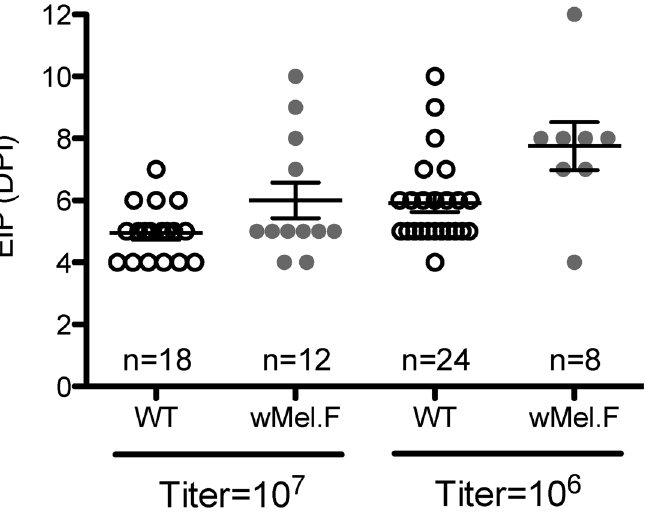
Fig 1. Extrinsic incubation period (DPI) of WT (white) and Wolbachia infected ( w Mel.F) mosquitoes (grey). Bars depict means ± S.E.M. Mosquitoes were orally infected with either 10 7 or 10 6 PFU/ml of DENV. Each data point represents a pool of 10